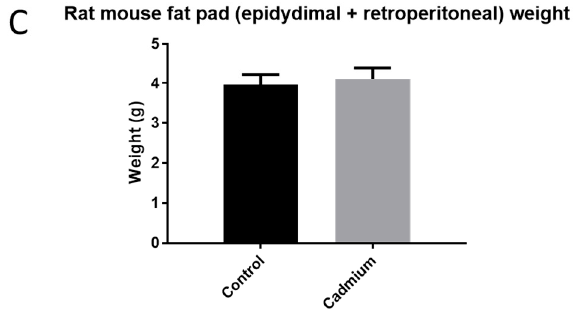
Figure 4. Changes in fat pad weights (epidydimal and retroperitoneal) after two weeks of 0.6 mg/kg/b.w./day of Cd dosing and two subsequent weeks of no Cd dosing for db/db mice ( A ), lean mice ( B ) and rats ( C ). Time point “0” is when last Cd dose was administered. Asterisk (*) indicates significant differences between Cd-treated and control animals. Two-way ANOVA with Tukey’s multiple comparison post-tests test; p ≤ 0.05 was considered significant; N = 4 per group for mice and N = 6 for rats per group; data are mean ± SE.